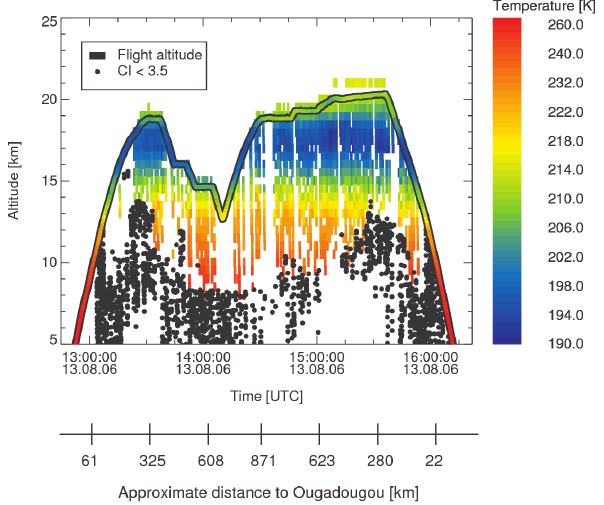
Fig. 7. CRISTA-NF and TDC temperatures during flight L5. The TDC temperatures are plotted along the flight altitude with the same color scale as the 2-D representation of CRISTA-NF temperatures. Black dots mark spectra with a CI lower than 3.5. Note the non- linear color scale.